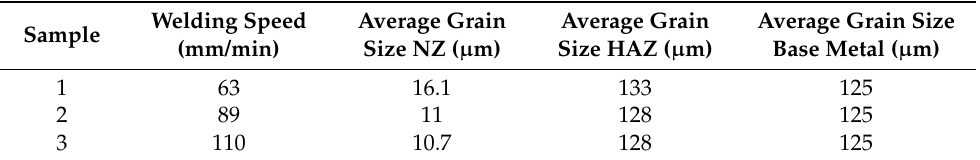
Table 5. Grain size of Nugget Zones (NZs) and Heat Affected Zones (HAZs).